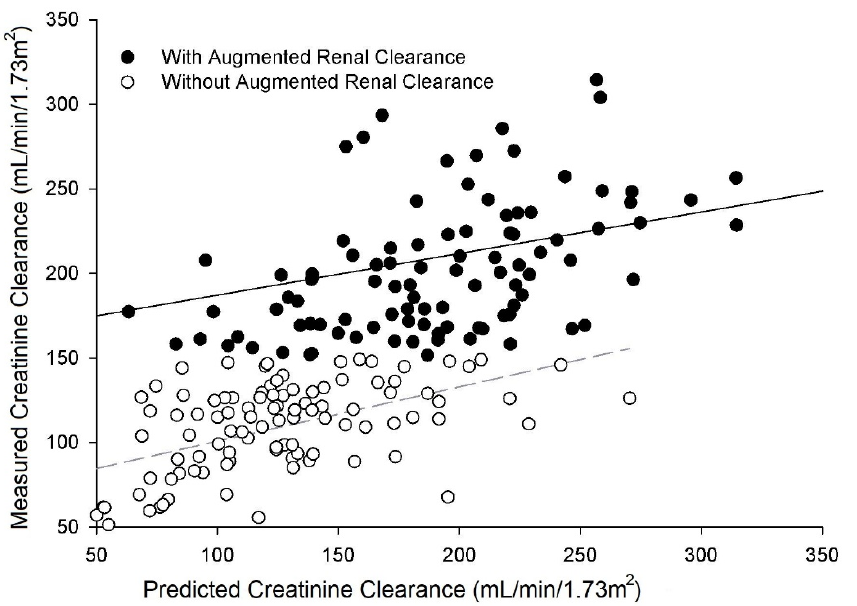
Figure 2. Relationship between measured (mCrCL) and predicted (Cockcroft–Gault equation) creatinine clearance (pCrCL) for patients with and without augmented renal clearance. Regression equations for each group, respectively, were: mCrCL ml/min/1.73 m 2 = 0.25 × pCrCL (mL/min/1.73 m 2 ) + 163 ( r = 0.23, p = 0.018) and mCrCL mL/min/1.73 m 2 = 0.32 × pCrCL (mL/min/1.73 m 2 ) + 69 ( r = 0.52, p = 0.001). The regressions for those with and without ARC, adjusted for predicted creatinine clearance, were significantly different from each other by ANCOVA ( p = 0.001). Table 5. Univariate correlation analysis between measured creatinine clearance and associated vari-